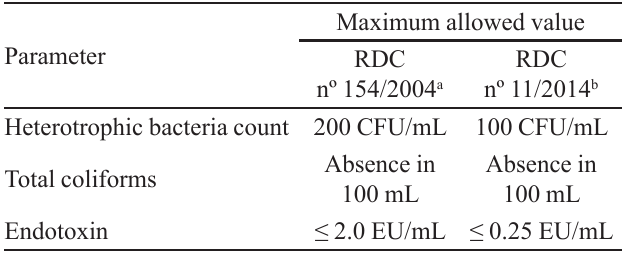
TABLE I – Microbiological quality standard for hemodialysis water in Brazil